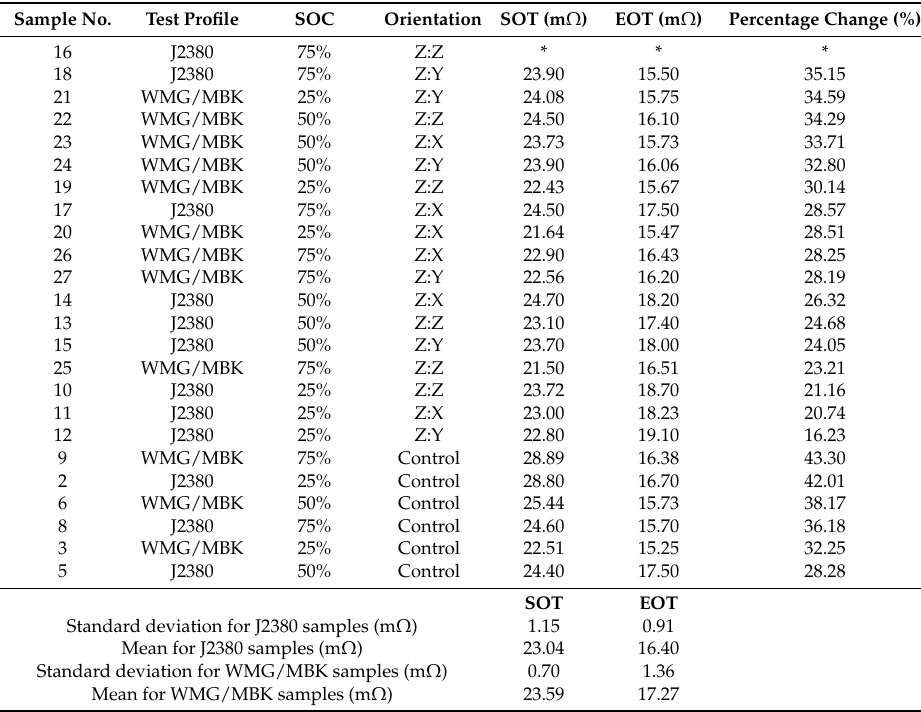
Table 13. EIS charge transfer resistance (R CT ) results for all tested samples. Sample